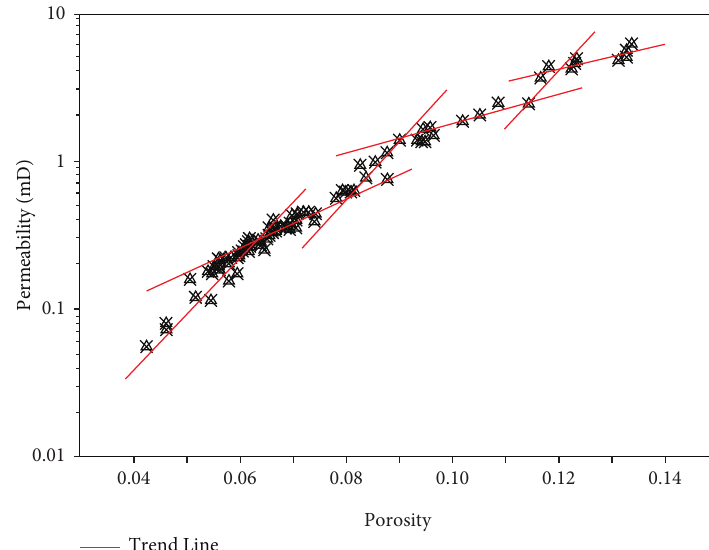
Figure 2: Porosity and permeability relationship and corresponding trend